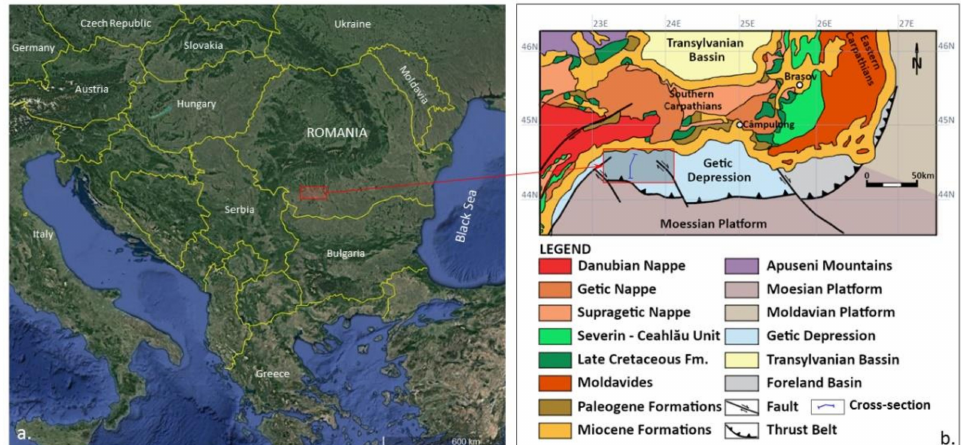
Figure 1. ( a ) Occurrence of the studied area (Google Earth source); ( b ) Simplified tectonic map of the Getic Depression, and of the South and East Carpathians, with the studied area marked as rectangular figure. Modified from